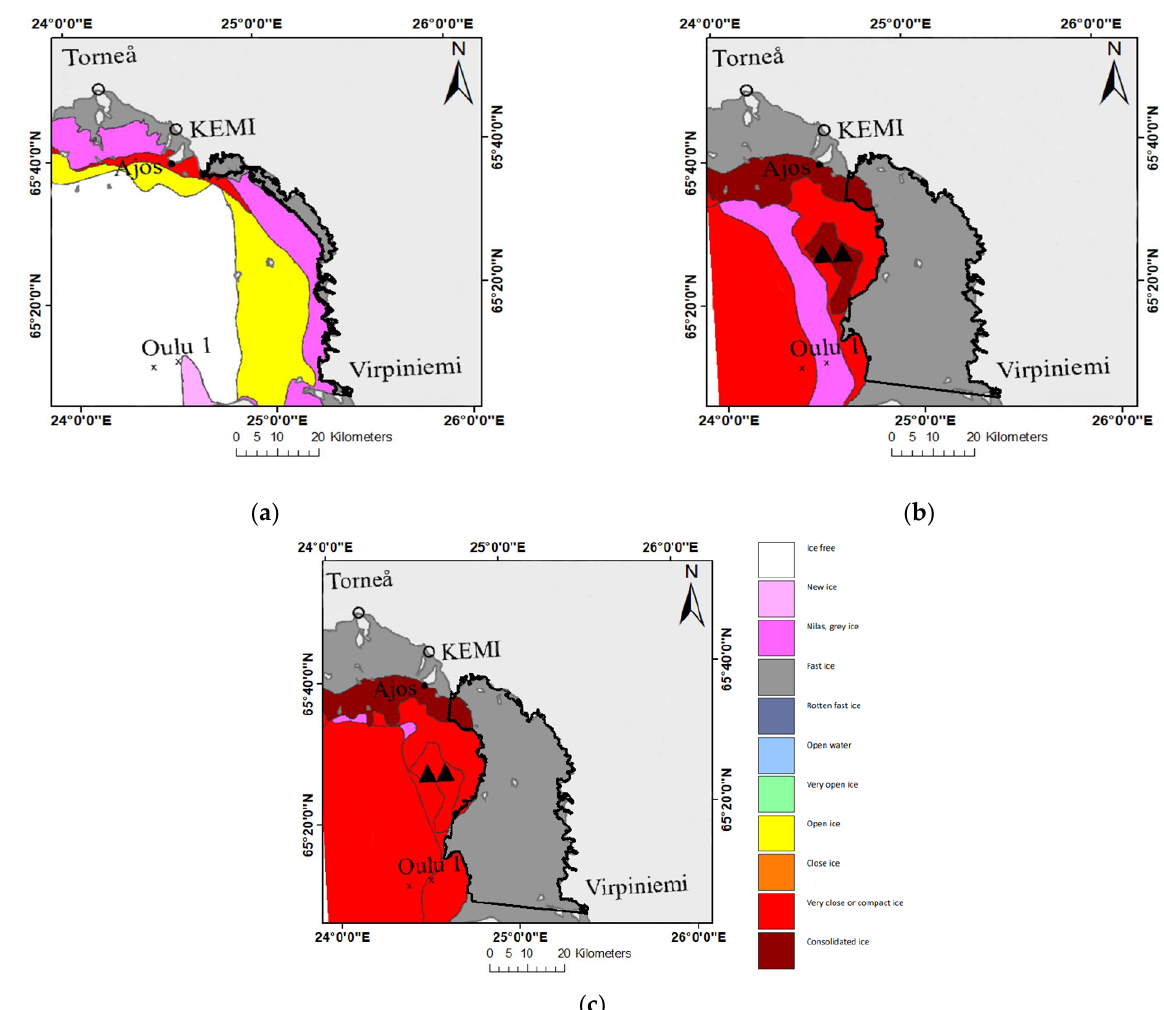
Figure 8. The extracted landfast ice edge comparing to ice charts: ( a ) The ice chart corresponding to image pair 2; ( b ) The ice chart corresponding to image pair 3; ( c ) The ice chart corresponding to image pair 4. The black curve represents the landfast edge lines extracted in this paper.